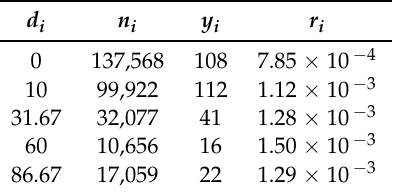
Table 1. Raw data derived from the asthma association study [70] (Table 2). The study lasted from 1990 to 1996 and accounted for 297,282 person-years. In this table d i represents the dose-level, n i the number of subjects in each dose-group, y i the number of subjects with effect in the corresponding dose-group and r i is the dose-response computed as the ratio y i / n i .